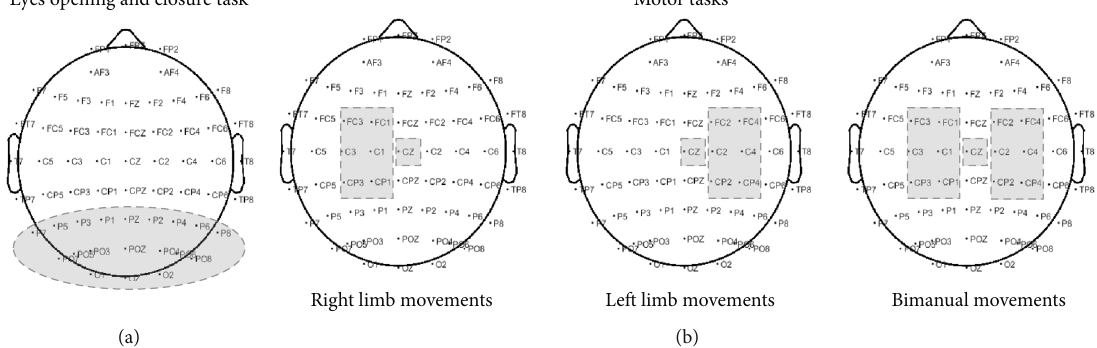
Figure 1: Schematic representation of the electrode clusters selected for the quanti fi cation of visual alpha (a) and mu and beta motor rhythms